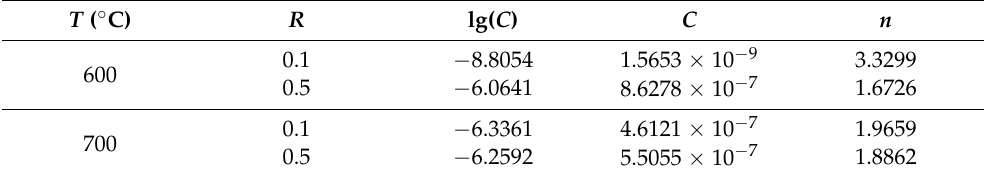
Table 4. Fitting parameters for the Paris model.